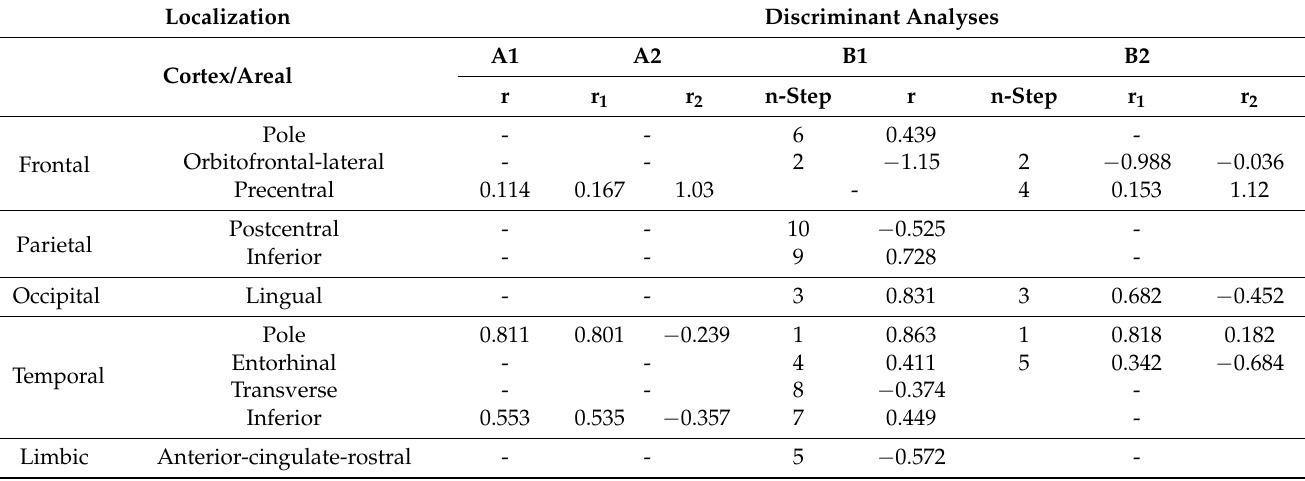
Table 5. Functions of discriminant analyses. Standardized canonical function coefficients (r) of the discriminant analyses for all involved ROIs. If the discriminant analysis provides a distinction between UMN, LMN and HeaCON (2), the coefficients for both functions are shown (r 1 , r 2 ). For stepwise analyses (B) the step number in which the ROI was added is given (n-step). HeaCON, healthy controls; LMN, lower motor neuron patients; UMN, upper motor neuron patients. Localization